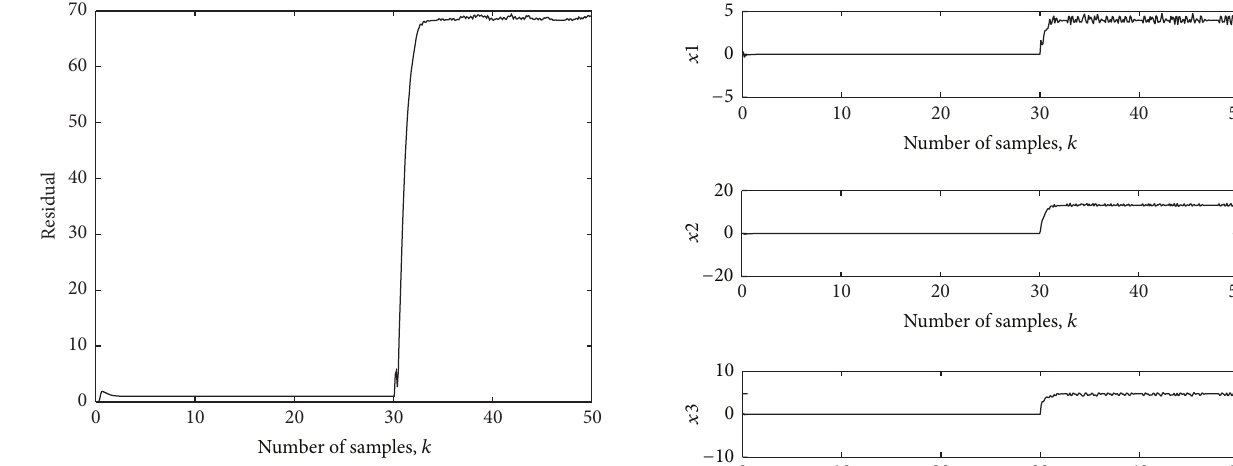
Figure 1: System residual signal with fault.